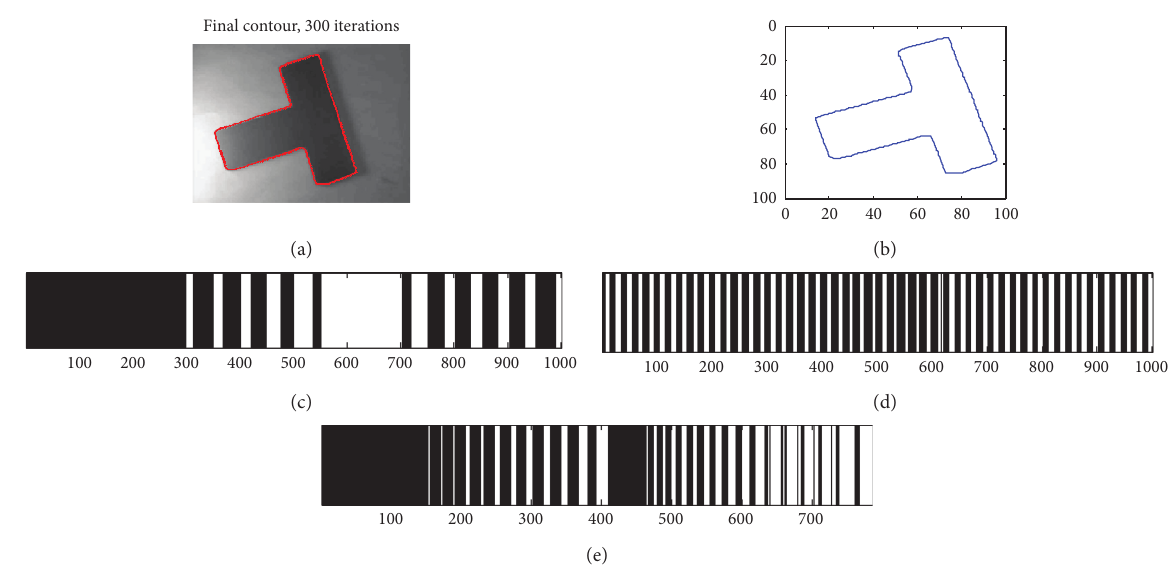
Figure 3: Image coding results with the binarized threshold coefficient of 0.7. (a) Row set LCV model image segmentation result. (b) Image contour. (c) Coding chain result of the contour boundary in row direction. (d) Coding chain result of the contour boundary in column direction. (e) Coding chain result of the contour boundary in oblique direction.